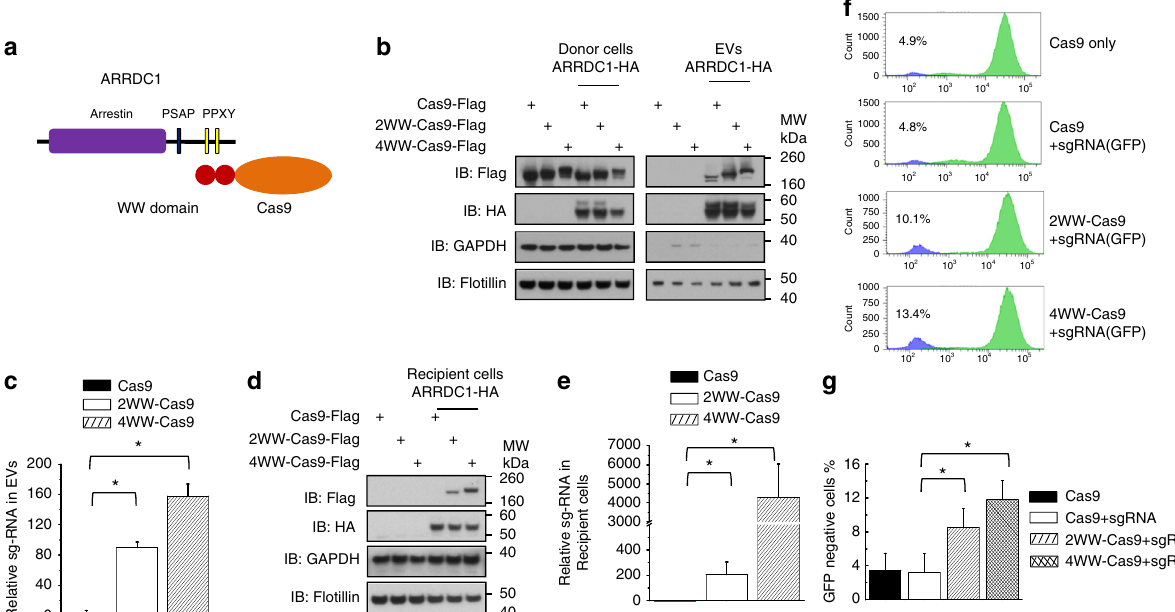
Fig. 3 Packaging and delivery of CRISPR-Cas9 via ARMMs. a Cas9 packaging strategy. Cas9 is fused to WW domains, which interacts with PPXY motifs of ARRDC1, allowing the recruitment of Cas9 into ARMMs. b Western blotting showing WW-linked Cas9 in EVs. HEK293T cells were transfected with Cas9, 2WW-Cas9, or 4WW-Cas9 together with pCDNA3.1 or ARRDC1-HA. Extracellular vesicles were pelleted by ultracentrifugation. Both cell lysates and extracellular vesicle (EV) pellets were subjected for anti-Flag, anti-HA, anti GAPDH, and anti- fl otillin Western blotting. RNAs were also extracted from EV fractions for qRT-PCR quanti fi cation of guide RNA ( c ). d Transfer of WW-domain linked Cas9 proteins in ARMMs to recipient cells. HEK293T cells were incubated with different ARMMs overnight, washed with PBS extensively, and subjected to Western blotting. RNAs were also extracted from the recipient cells for qRT-PCR quanti fi cation of guide RNA ( e ). f Flow cytometry data showing the WW-domain linked Cas9 functioned in the recipient cells, which were U2OS cell with stable expression of GFP protein. g Quanti fi cations of fl ow cytometry data ( f ) from three independent replicates. Data were presented as the mean ± SD in the bar graphs. * p <